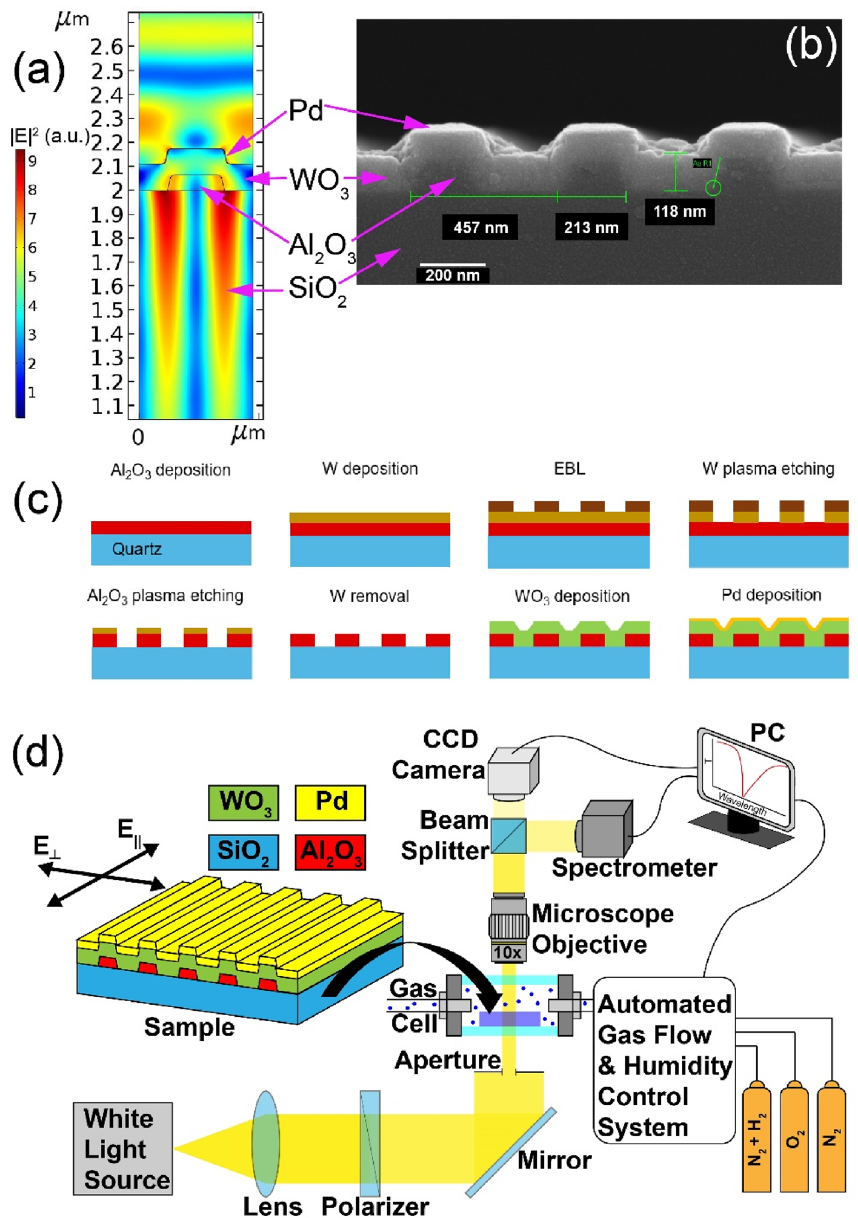
setup for measurement of transmission spectra ( d